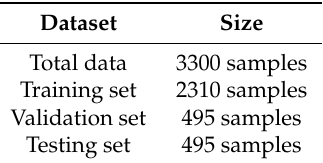
Table 1. Dataset distribution for the preliminary